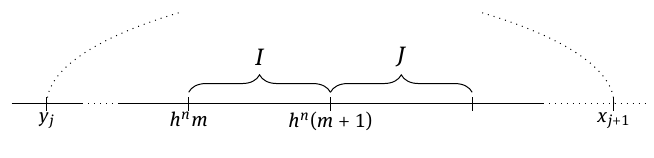
Figure 2: The shortcut ( y j , x j +1 ) across I .